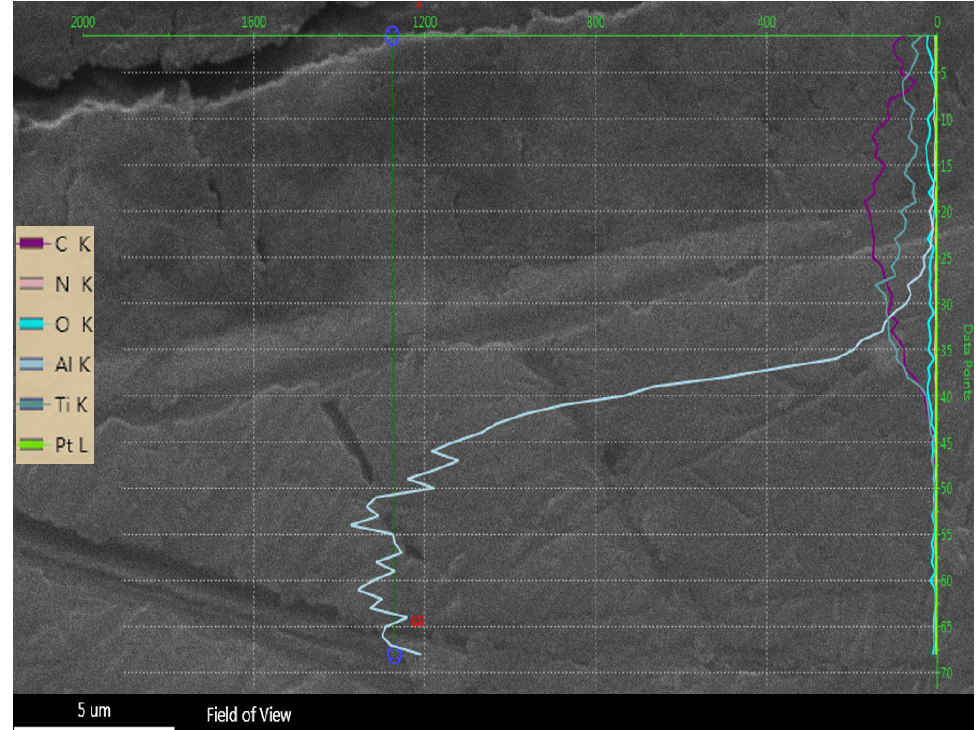
Figure 12. Linear analysis of particle distribution.